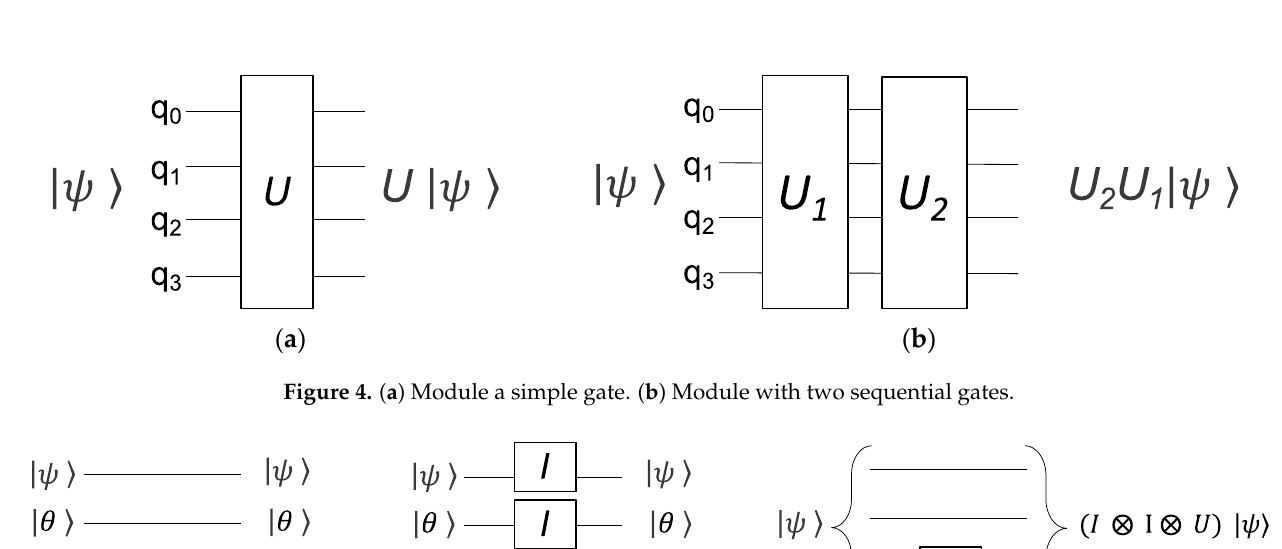
Figure 4. ( a ) Module a simple gate. ( b ) Module with two sequential gates.